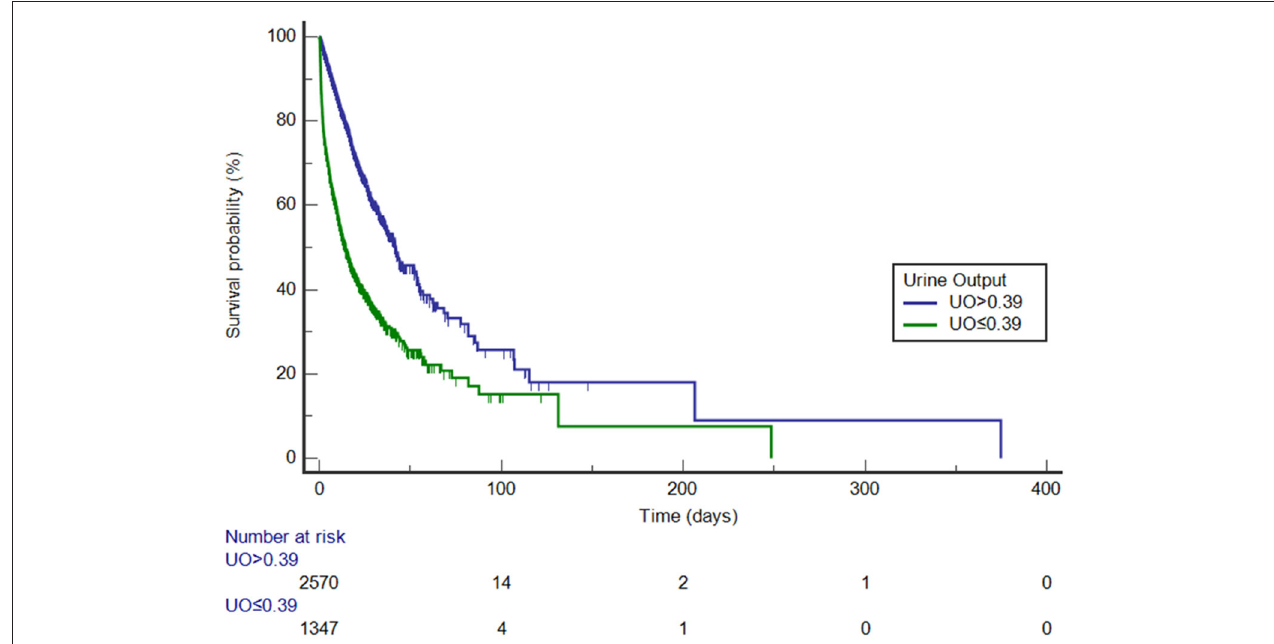
FIGURE 4 | Kaplan-Meier survival curves by urine output category (after propensity score matching, log-rank P < 0.0001). UO, Urine Output (mg/kg/h).